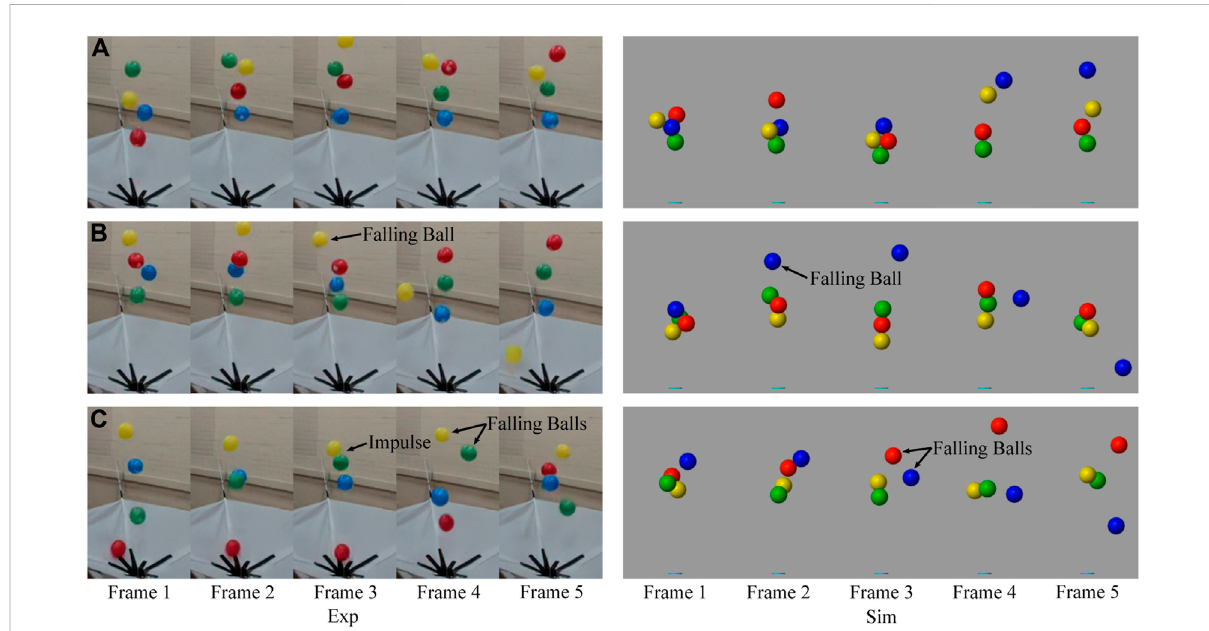
FIGURE 2 Frame arrays of several typical collective behaviors showing collaboration and competition in both experiment and simulation, like win-win situation (A) ,kick-outeffect (B) ,andlose-losesituation (C) .Especially,thelose-losesituation (C) intheexperimentiscausedbytheimpulsebetween the green ball and the yellow